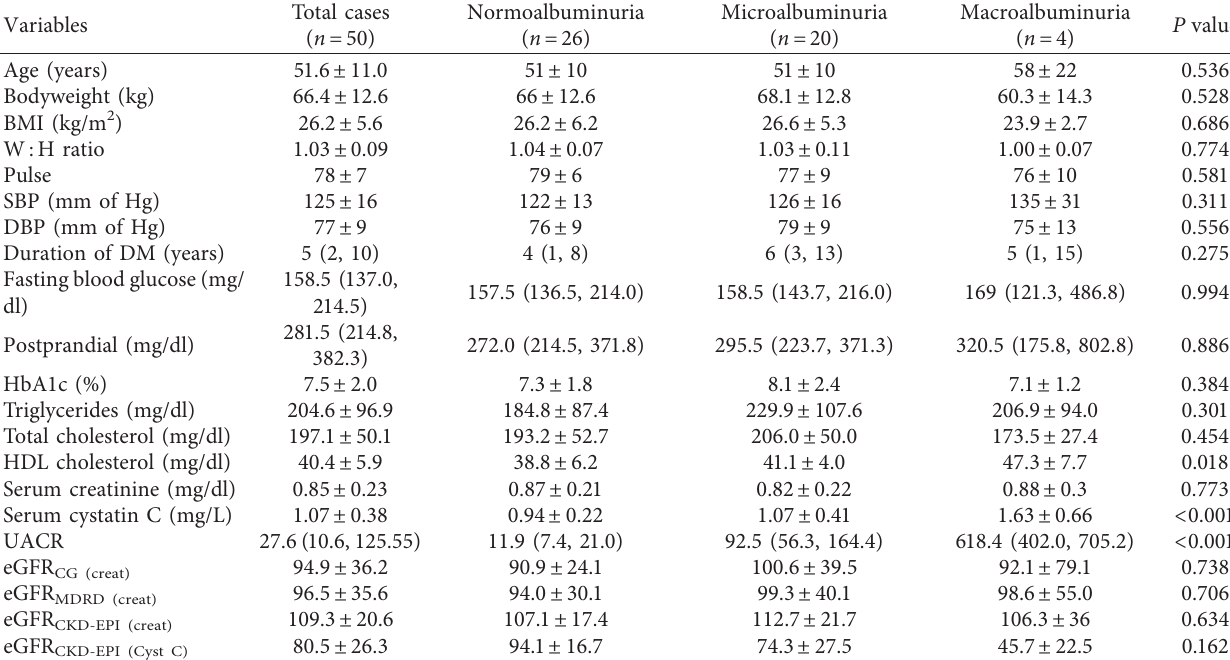
Table 2: Variables according to different grades of diabetic nephropathy.